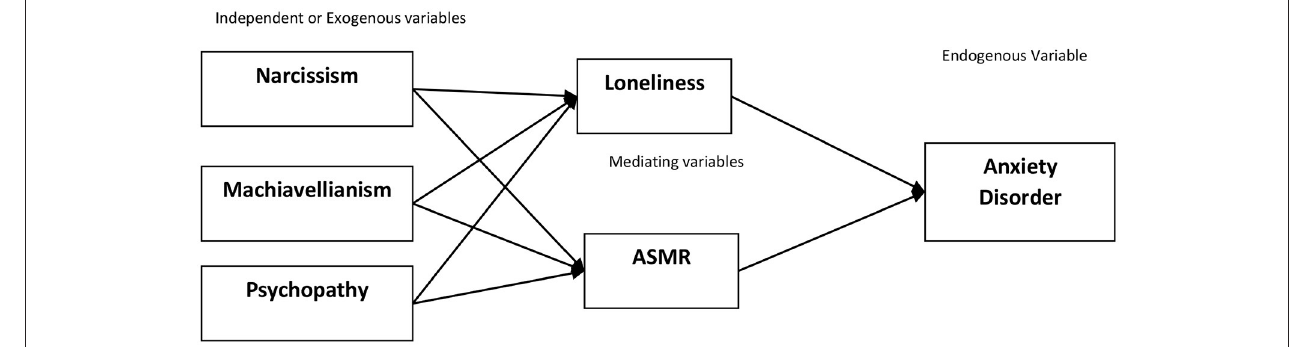
FIGURE 1 | Conceptual